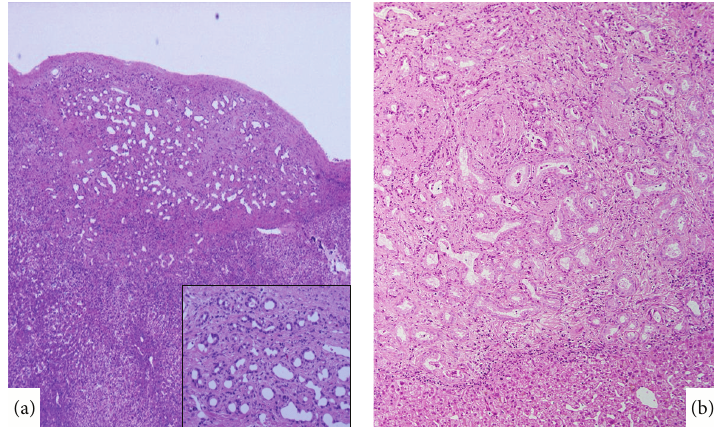
Figure 1: Bile duct adenoma. (a) Ordinary bile duct adenoma is seen under hepatic capsule, and it is composed of well-developed bile ducts of interlobular bile duct sizes (inset). HE. (b) Occasionally, bile duct adenoma with columnar epithelium and plenty cytoplasm shows compact growth. HE.